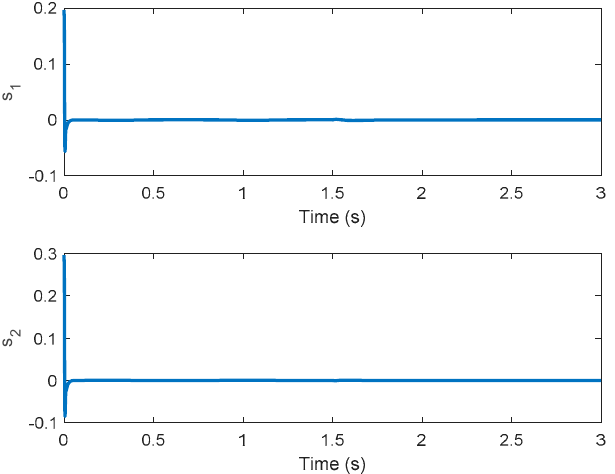
Figure 9. Control inputs based on the flexible PID controller and unknown perturbation.